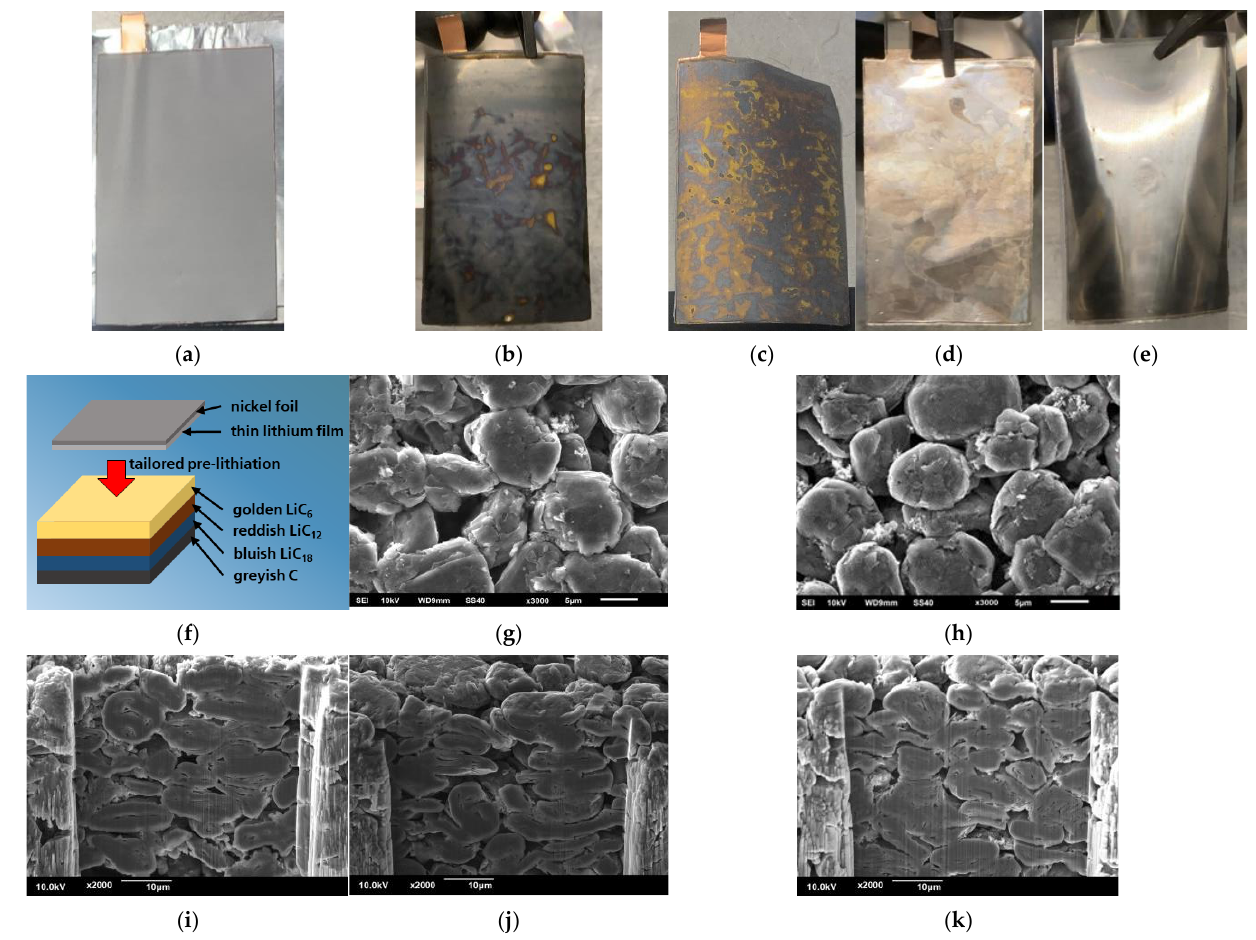
Figure 3. Photograph of an unlithiated graphite electrode ( a ), a 7% pre-lithiated ( b ) and a 50% pre- lithiated ( c ) graphite electrode directly after static pressing; temporary substrate with ~6 µm Li ( d ) and temporary substrate with no lithium left over after pressing ( e ); schematic illustration of the lithium distribution during pre-lithiation showing a lithium concentration gradient from the top to the bottom of the graphite electrode in different colors due to different diffraction coefficients ( f ); SEM top view of graphite electrodes 7% lithiated ( g ) and unlithiated ( h ); SEM of focused ion beam (FIB) cut graphite electrodes 50% pre-lithiated ( i ), 7% pre-lithiated ( j ) and unlithiated ( k ) showing no structural change of the graphite material after pressing under temperature and pressure influ- ence.